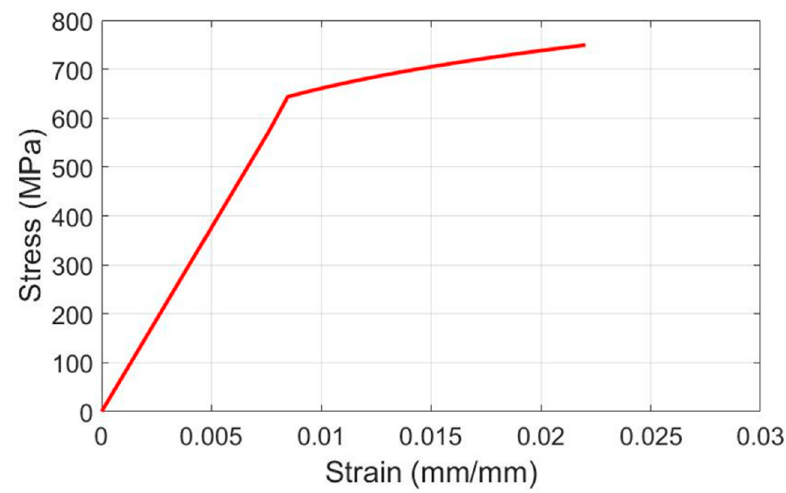
Figure 2. Stress-strain curve of Zircaloy-4 cladding obtained by the PNNL model [6].